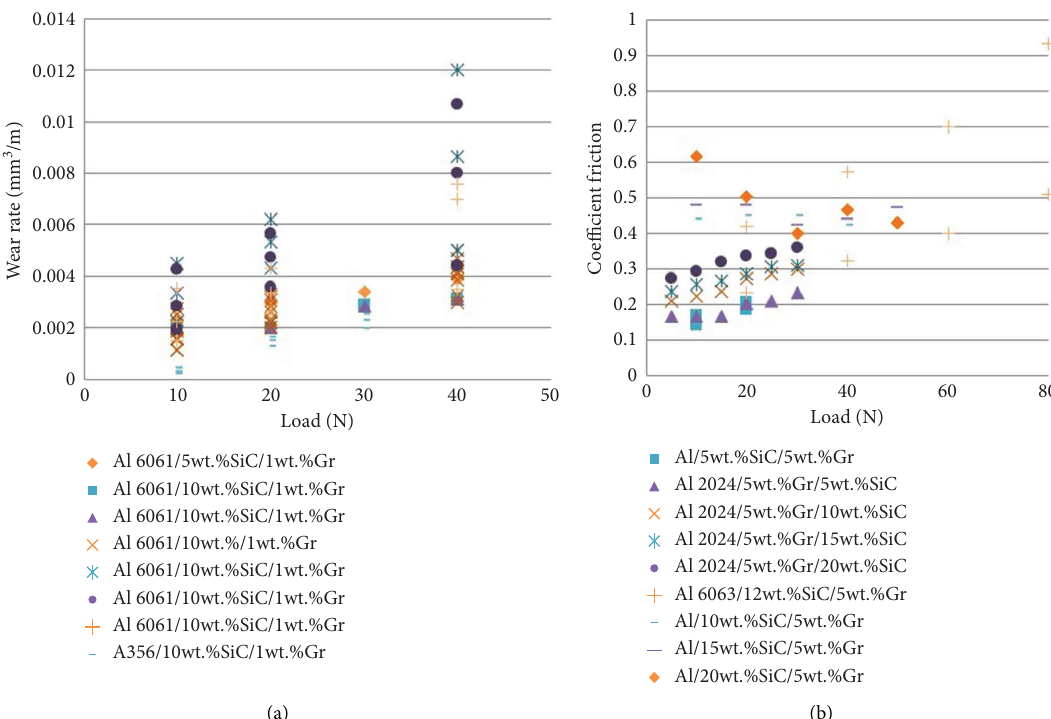
Figure 17: 'e influence of load on the friction coefficient of Al/SiC/Gr HAMCs with various SiC particle wt% and fixed (a) 1 wt% Gr, (b) 5 wt% Gr. Adapted with permission from Ref. [113], copyright 2018, EDP